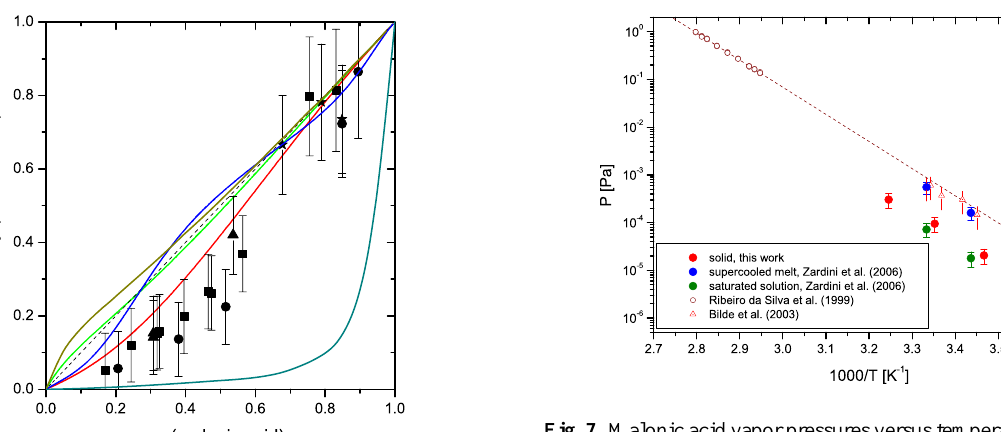
Fig. 7. Malonic acid vapor pressures versus temperature, solid sym- bols: this work and Zardini et al. (2006); Open symbols: literature data as indicated in the figure. Dotted line: extrapolation of high temperature data (Ribeiro da Silva et al., 1999) to ambient temper-